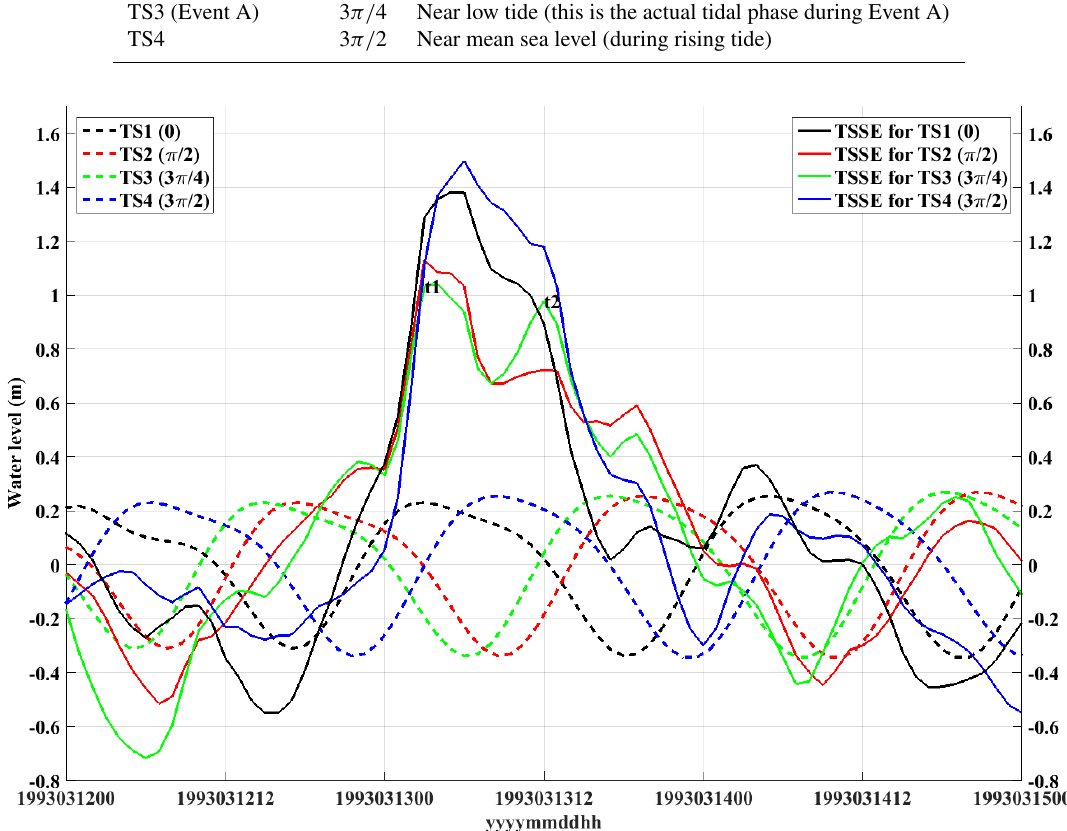
Figure 4. Tide forcing for the four scenarios at Progreso, for Event A (dashed lines); time series of TSSE at Progreso (continuous lines) associated with each scenario. For each tide scenario see Table